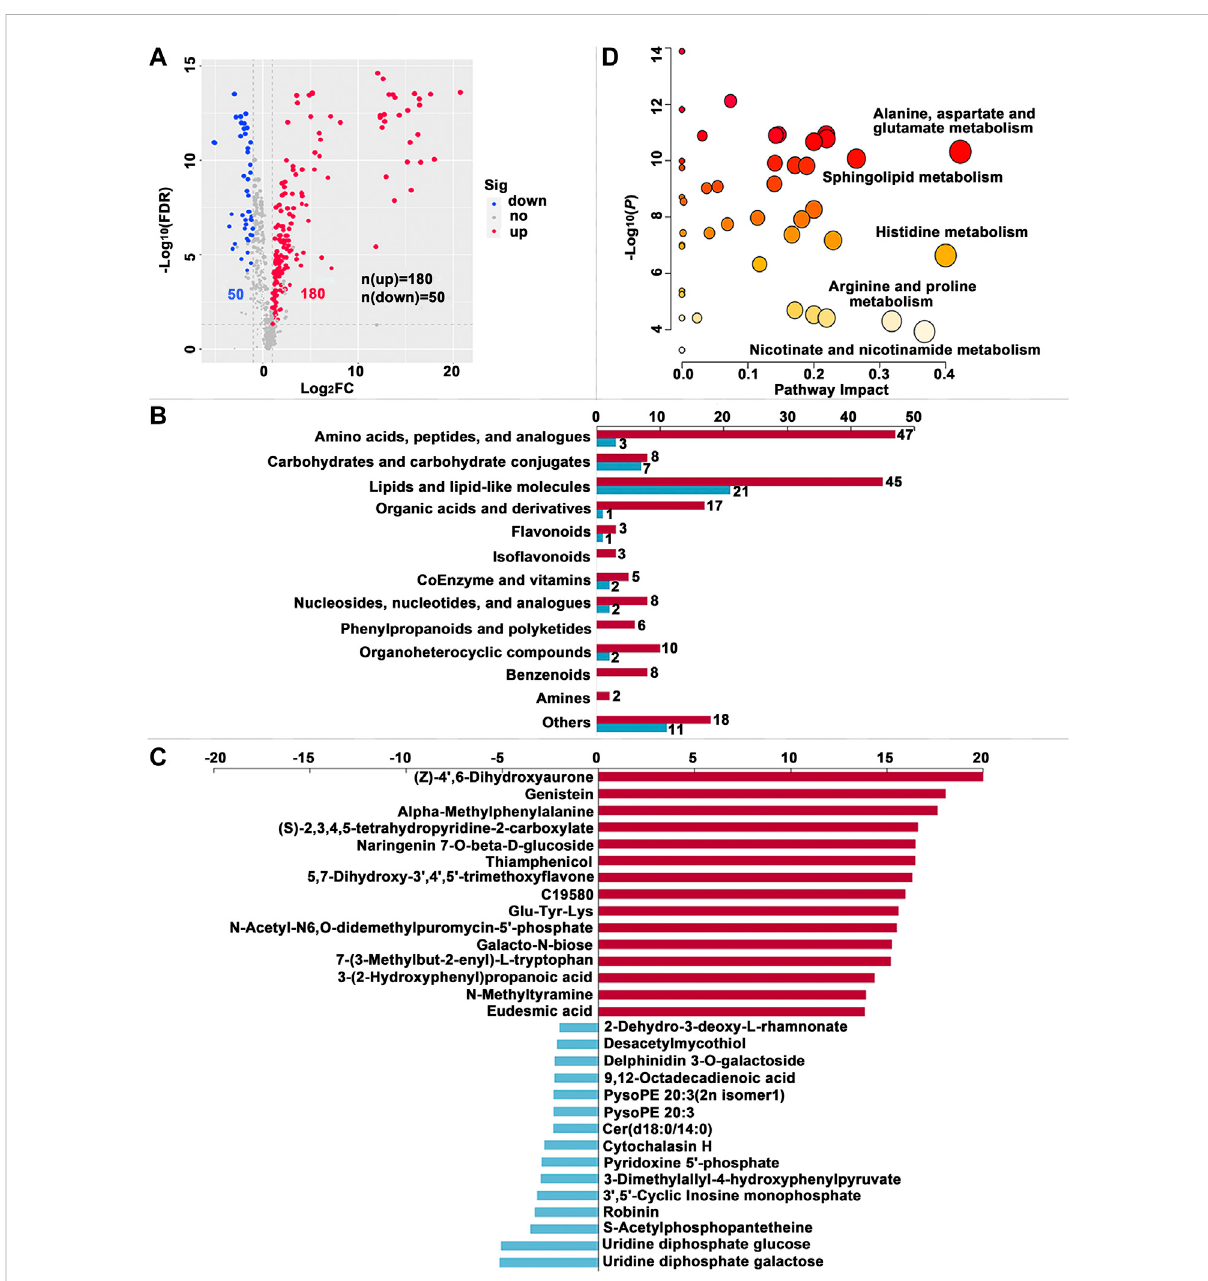
Signi fi cantlydifferent metabolites(SDMs) and enrichedpathways relating to different diets in themidgut(MG). (A) Volcano plots of metabolitesfor theformulafeed(FF)andthemulberryleaves(ML)silkwormsintheMG.Thereddotrepresentsthemetaboliteissigni fi cantlyhigherintheFFsilkworms, and thebluedot indicatesa higherabundantmetaboliteintheMLsilkworms. The dot sizerepresentstheVIP value. (B) SDMsclassi fi cationand variation between the FF and ML group. The blue and red bar indicate the number of downregulated and upregulated metabolites in the MG of FF group, respectively. (C) The top 15 upregulated SDMs and downregulated SDMs in the MG of the FF silkworms. (D) Metabolic pathways enriched by the SDMs between the FF and ML groups in the MG. C19580,